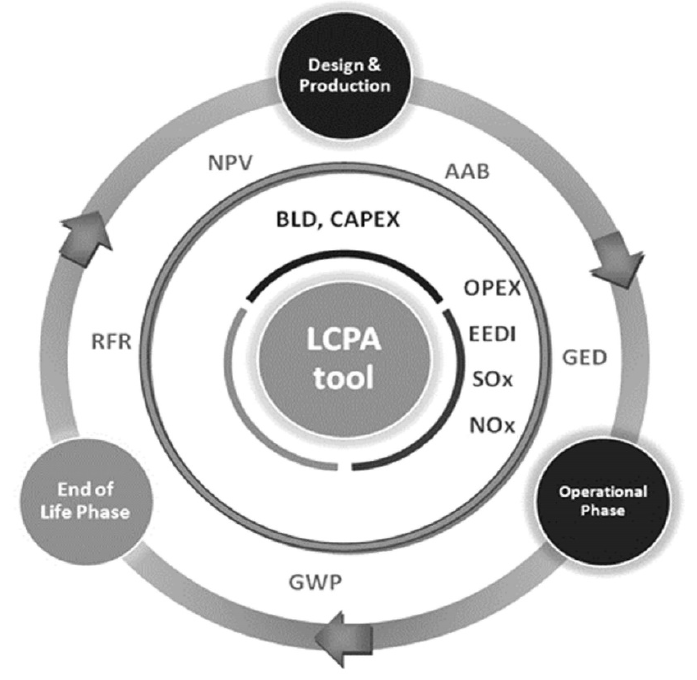
Figure 5. Stages of a vessel life cycle and HOLISHIP LCPA tool [10].